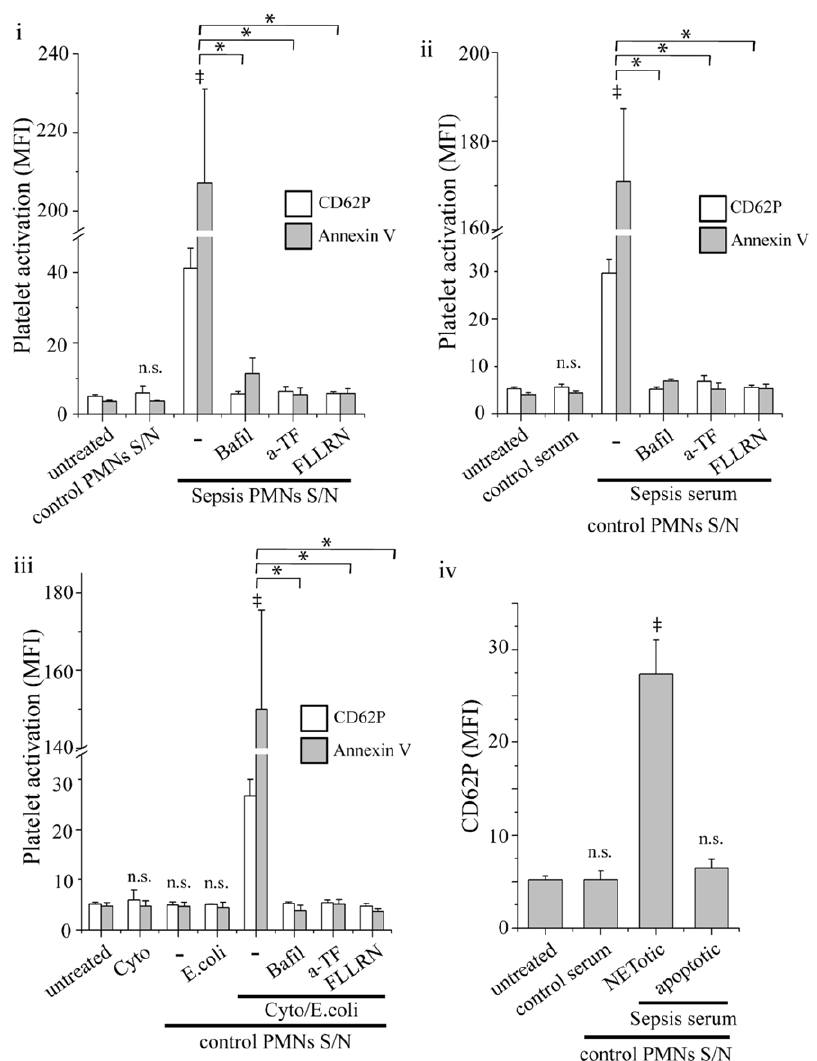
Figure 5. Platelet activation by NET-forming neutrophils. Expression of CD62P (white bar) and annexin V (grey bar) in (i) sepsis neutrophil, (ii) control neutrophils treated with sepsis serum or (iii) treated with E. coli (E.coli), or TNF- a , IL-1 b and G-CSF alone (Cyto) or primed with cytokines before the addition of E. coli (Cyto/E. coli). Treatment with bafilomycin A1 or anti-TF mAb in neutrophil cultures or inhibition of PAR-1 signaling in platelets with FLLRN inhibited this effect. (iv) CD62P expression in control platelets stimulated with supernatants (S/N) from control neutrophils treated with sepsis serum and subsequently irradiated to undergo apoptosis, or not. Untreated platelets from control subjects (untreated), or incubated with cytokines (Cyto) or with supernatants from control neutrophils treated with normal serum were used as controls. Expression of CD62P and annexin V was assessed by flow cytometry and presented as mean fluorescent intensity (MFI). Data are representative of four independent experiments and presented as mean 6 SD. (* P , .05, { P , .05 compared to control, ns = non